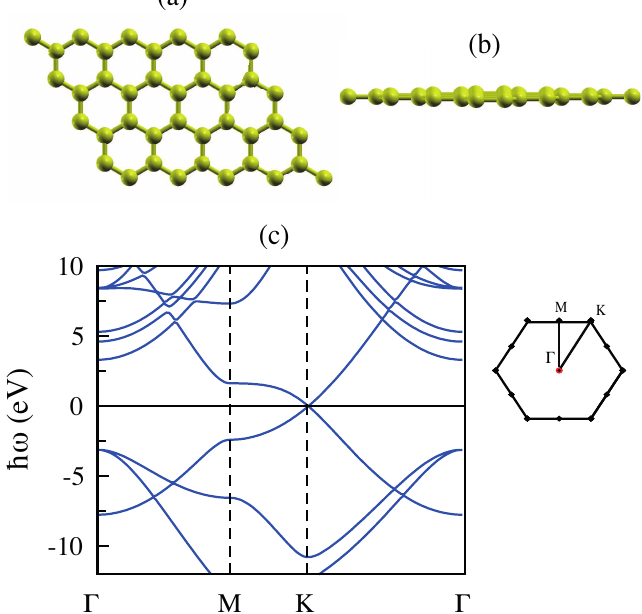
Figure 1. ( a , b ) Top and side view of monolayer graphene. ( c ) The band structure of graphene along the high symmetry Γ − M − K − Γ directions and the associated Brillouin zone. The zero in the energy axis is set at the Fermi level as shown by the solid